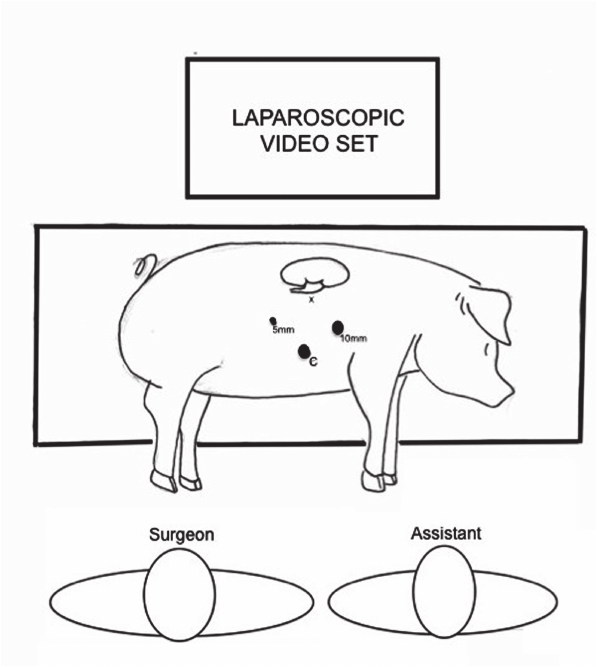
Figure 1 - Trocar placement - 3 ports were placed and a small puncture (“X”) was performed for the passage of the cannula for the glue